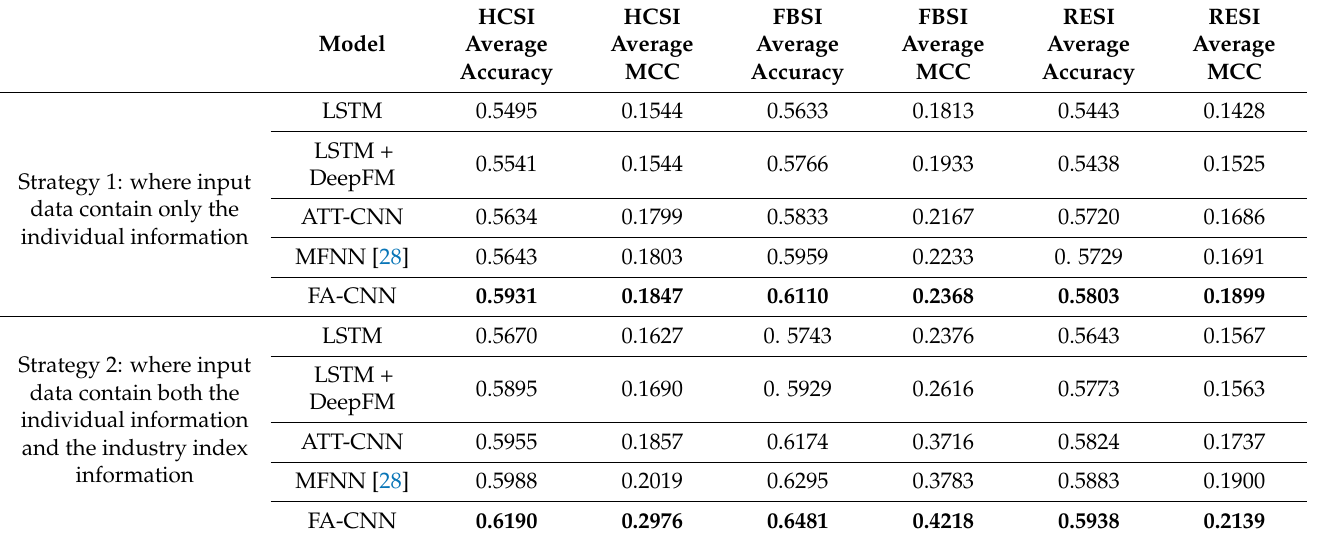
Table 2. The performance of different models with different